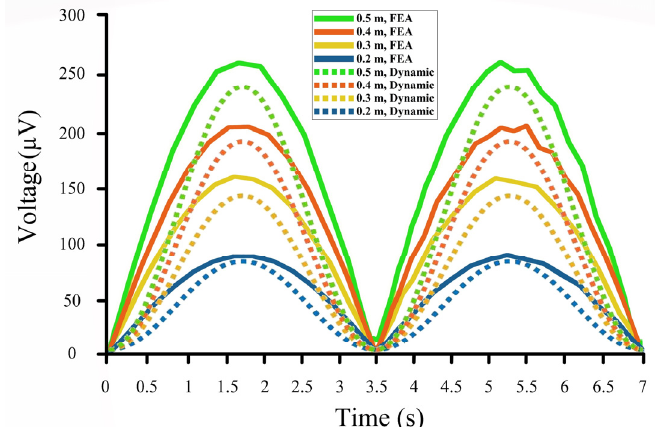
Figure 13. Results of the dynamic model (dashed lines) and the FEA simulation (lines).